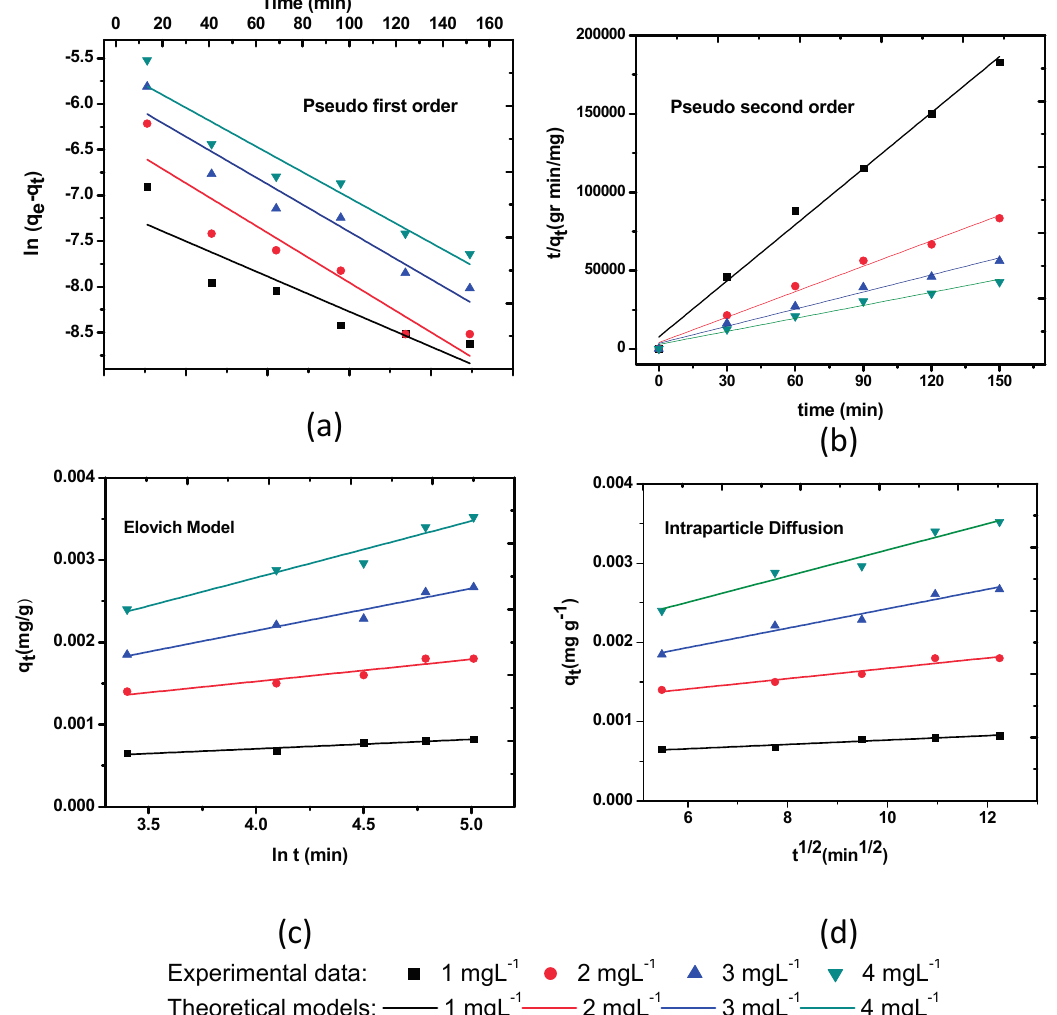
Figure 5. Graphs of the theoretical models corresponding to ( a ) the Lagergren pseudo-first- order model; ( b ) the second-order model; ( c ) the Elovich; and ( d ) the intraparticle diffusion